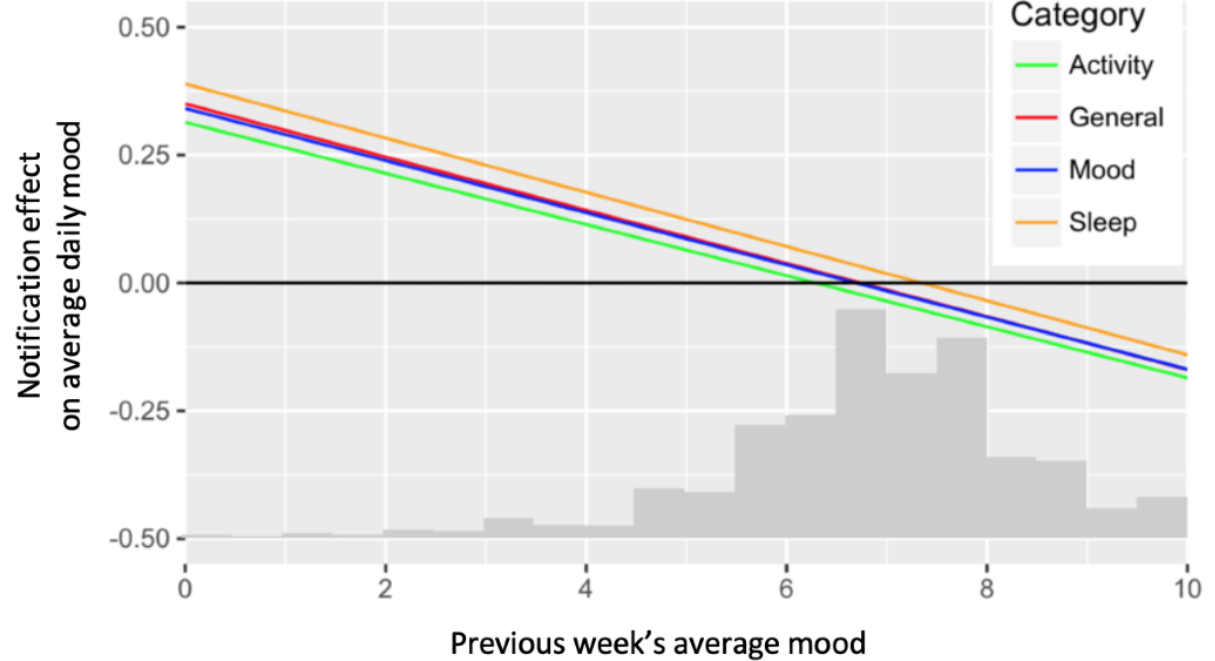
Figure 5. Estimated treatment effects (compared with no notifications) of different notification categories on average daily mood, at various values of